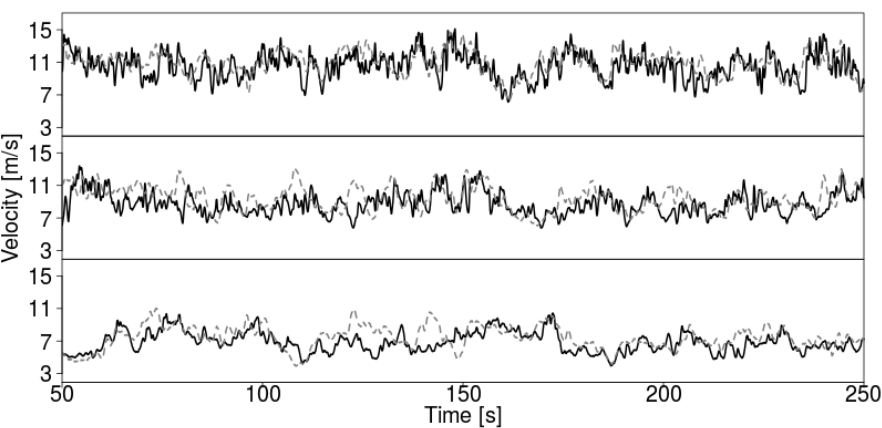
Figure 4. Wind velocity time series of BR (black, solid) and AL (grey, dashed) simulation for 0.5, 1 and 2 diameters (from top to bottom) at the centerline downstream of the rotor